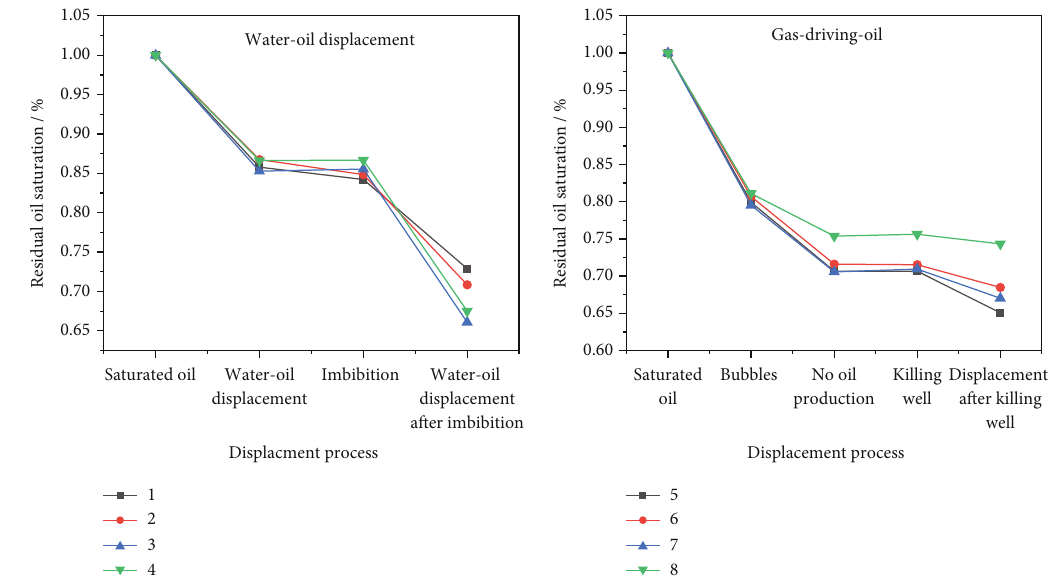
Figure 7: Diagrams showing the residual oil saturation in di ff erent states under two displacement modes.